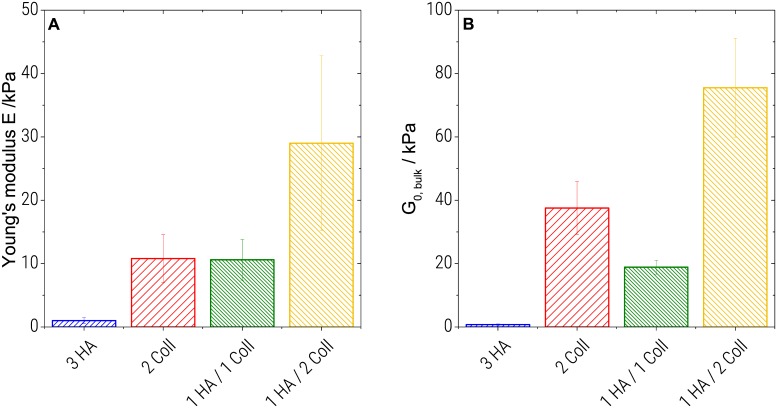
Bulk mechanics of cryogels.Young’s modulus determined in uniaxial compression (A) and shear modulus obtained from small amplitude oscillatory shear (B).